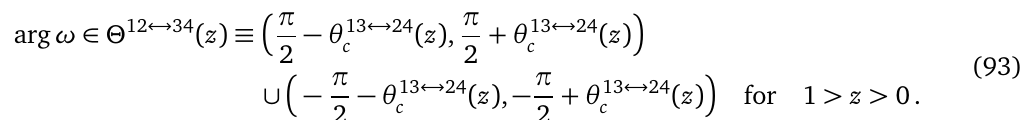
(cid:112) (cid:198) z m zm or ω = ± i , respec- i i z − 1